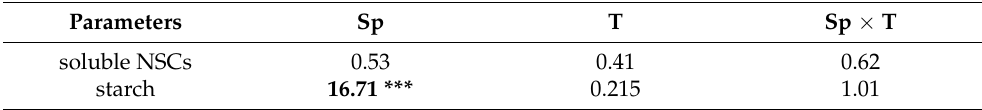
Table 6. Results of the two-way ANOVA analysis of parameters by species, Sp (i.e., laurel versus poplar) and time, T (i.e., Midday versus Morning). Numbers represent F values; *** = p < 0.001.